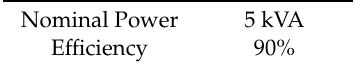
Table 9. Inverter / charger considered in the optimization.